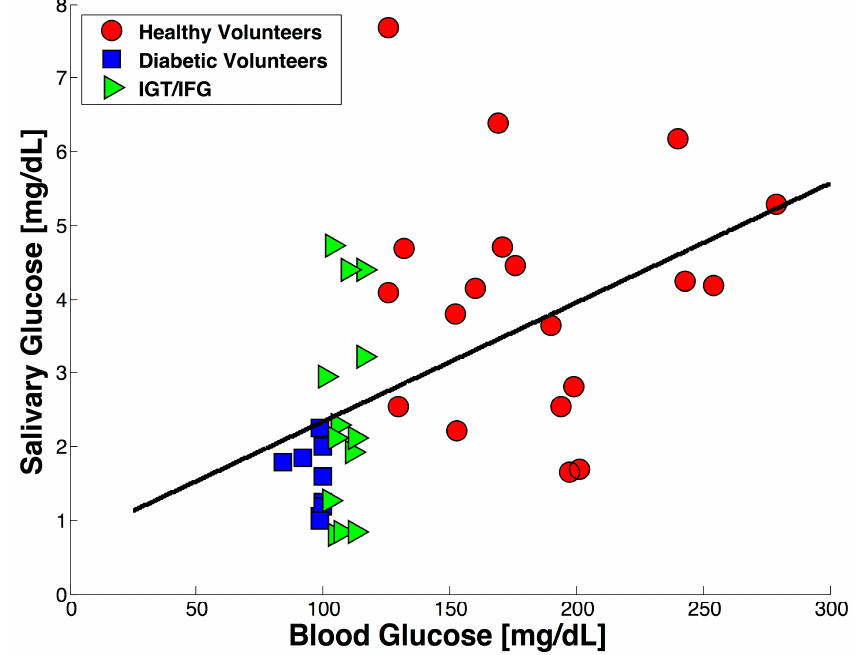
Figure 4. The distribution of salivary glucose concentration against blood glucose concentration for a group of 41 volunteers.